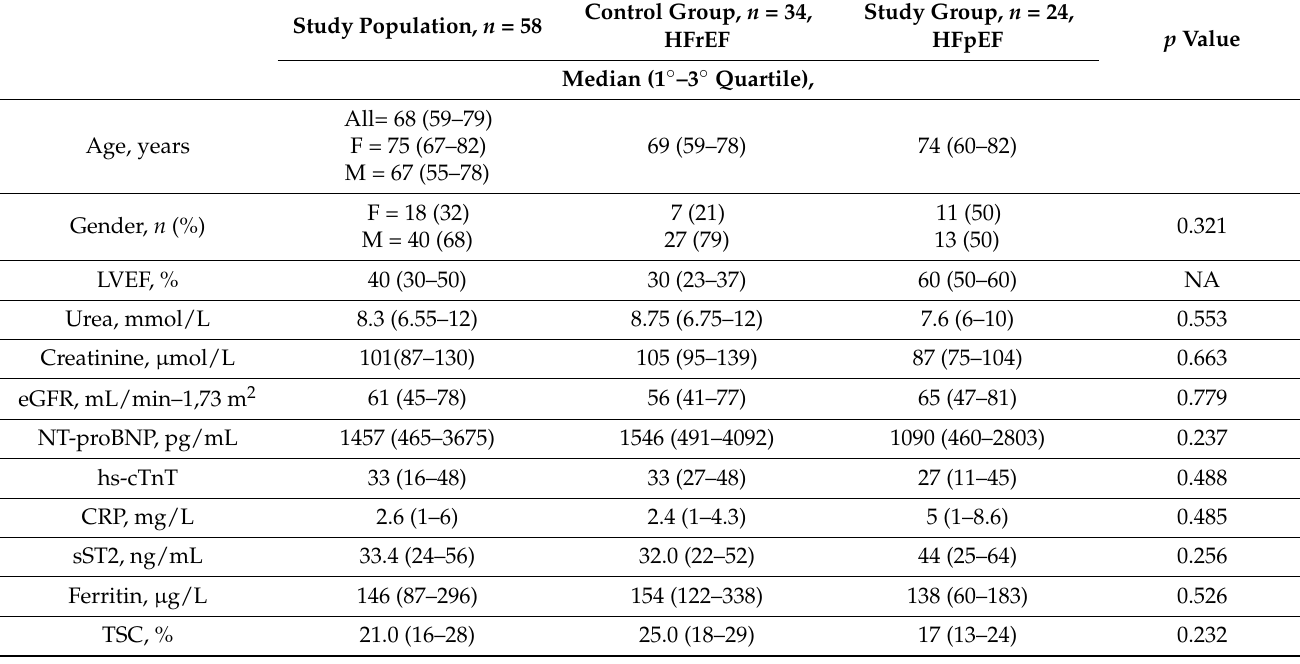
Table 1. Demographic characteristics, clinical biomarkers values, and results from logistic